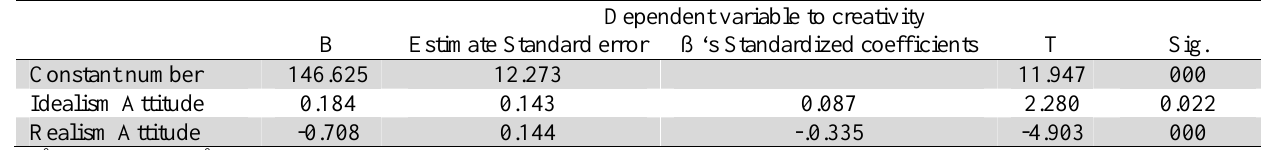
The summary of regression test to examine the relationship between creativity and realistic sense